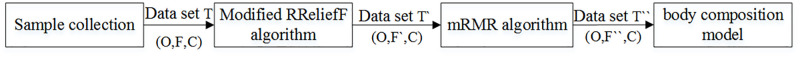
Selection process of human body physiological characteristic parameters.